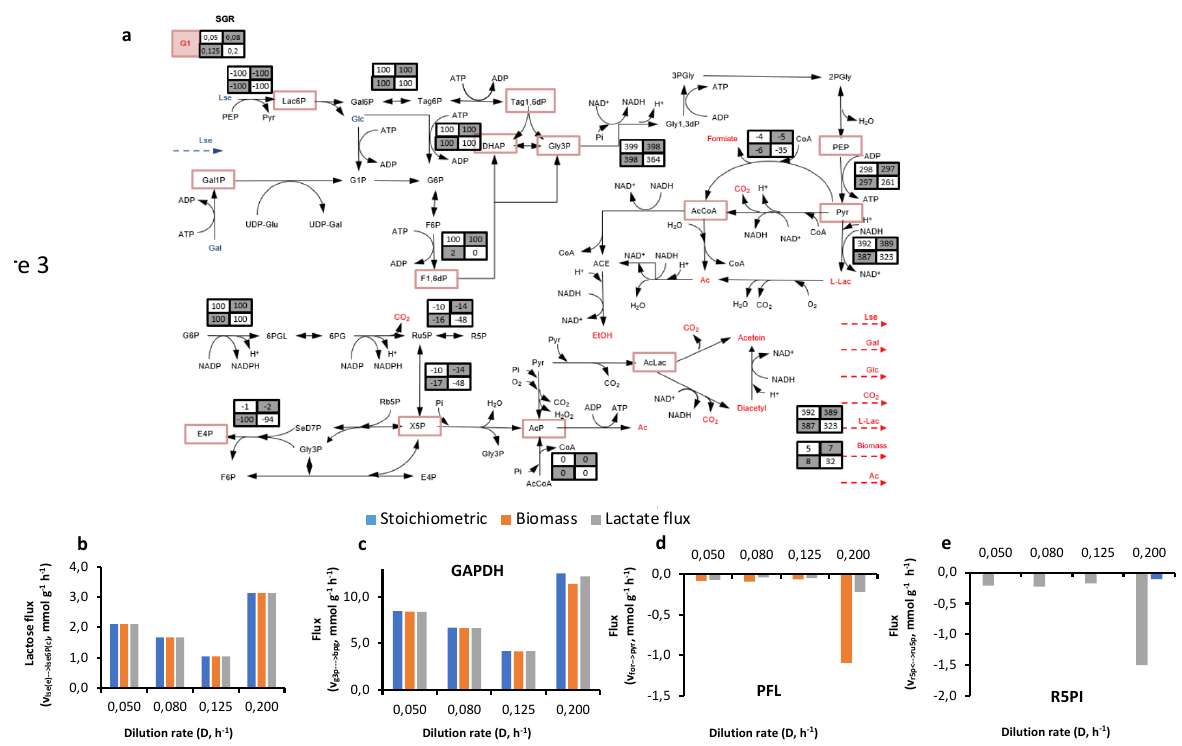
Figure 3. Metabolic map with restrictions caused by exchange reactions on the i Lca334_548 model. a) % flux i = (reaction flux i / lactose flux) × 100. Bar graph for lactose, b) GAPDH: Glyceraldehyde 3-phosphate dehydrogenase, c) PFL: pyruvate formate lyase, d) R5PI: Ribose-5-phosphate isomerase and e) fluxes using